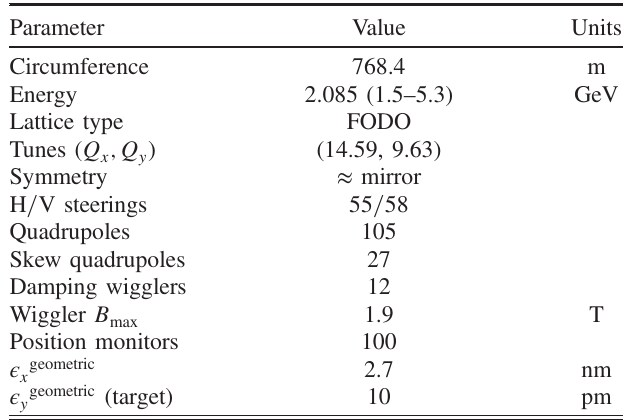
TABLE I. Parameters of the CESR electron/positron storage